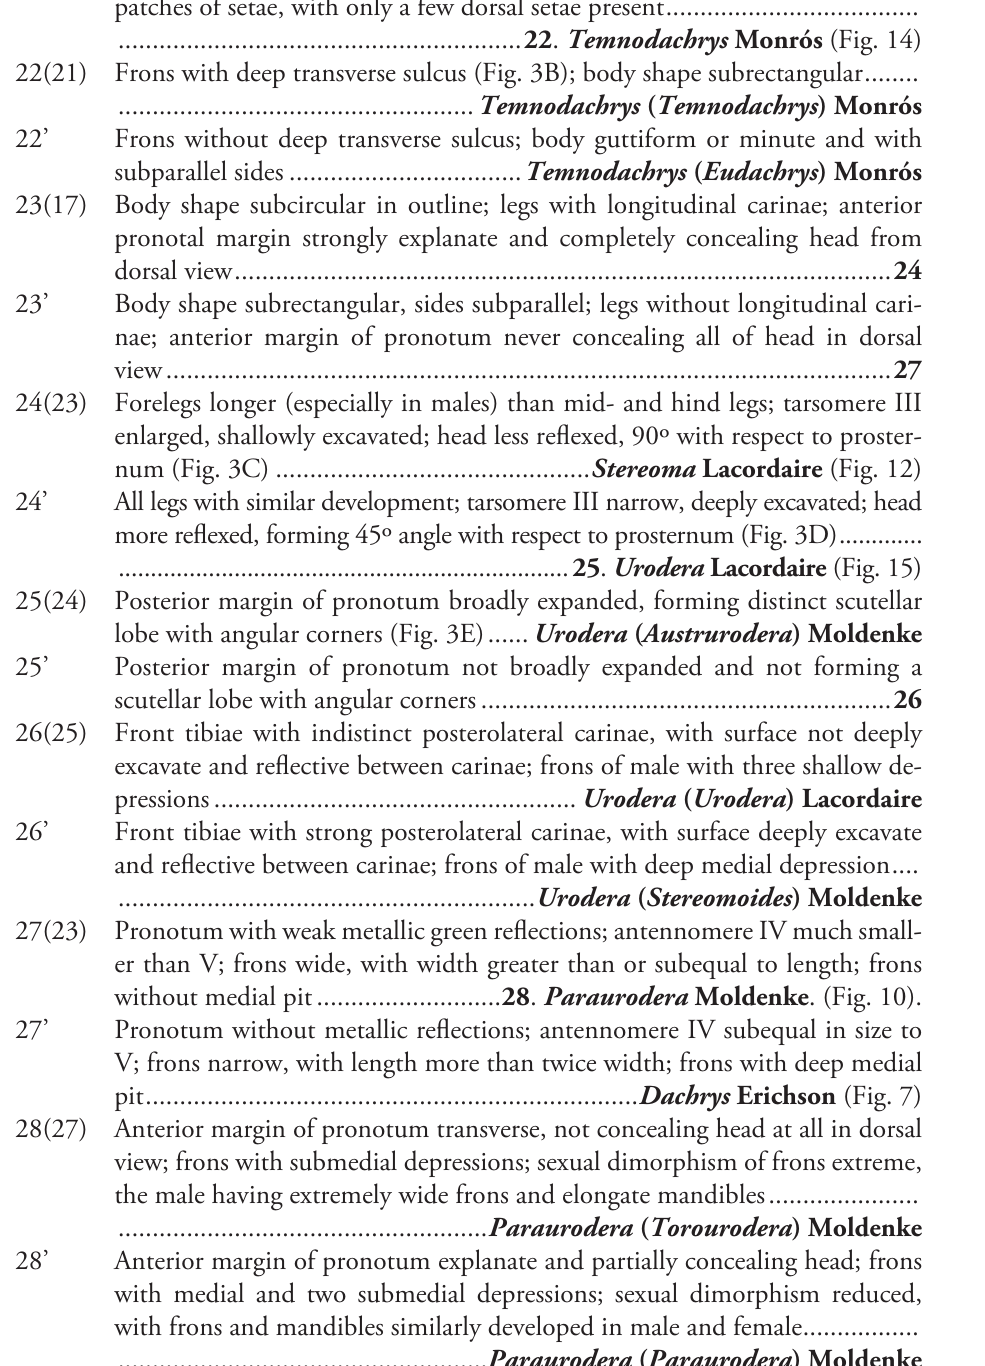
Posterior margin of pronotum not broadly expanded and not forming a Front tibiae with indistinct posterolateral carinae, with surface not deeply excavate and reflective between carinae; frons of male with three shallow de- 26’ Front tibiae with strong posterolateral carinae, with surface deeply excavate and reflective between carinae; frons of male with deep medial depression .... Pronotum with weak metallic green reflections; antennomere IV much small- er than V; frons wide, with width greater than or subequal to length; frons 27’ Pronotum without metallic reflections; antennomere IV subequal in size to V; frons narrow, with length more than twice width; frons with deep medial 28(27) Anterior margin of pronotum transverse, not concealing head at all in dorsal view; frons with submedial depressions; sexual dimorphism of frons extreme, the male having extremely wide frons and elongate mandibles ...................... 28’ Anterior margin of pronotum explanate and partially concealing head; frons with medial and two submedial depressions; sexual dimorphism